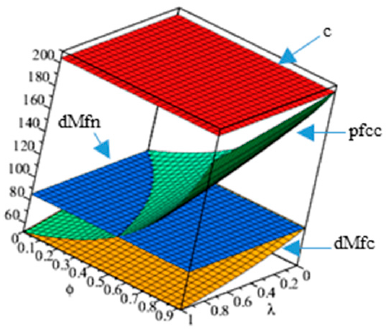
Figure 7. Effects of M’s fairness concerns on market demand.